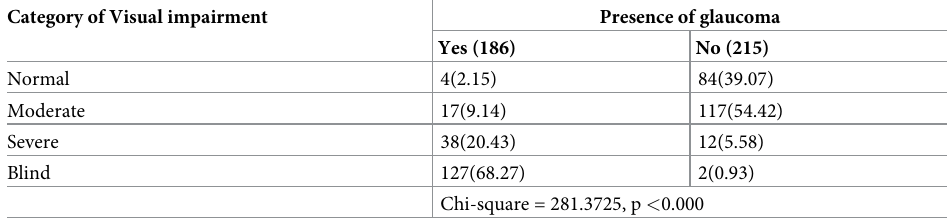
Table 5. Glaucoma and visual impairment.